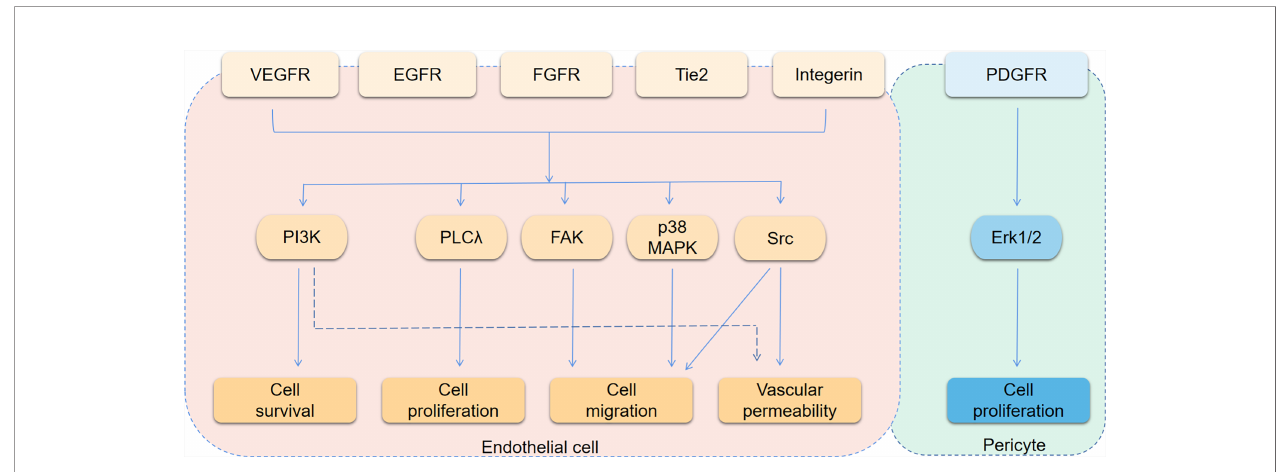
FIGURE 1 | Angiogenesis signaling pathways. The fi gure shows the main downstream pathways of receptors associated with angiogenesis. The main phenotypes affected by each pathway are indicated by